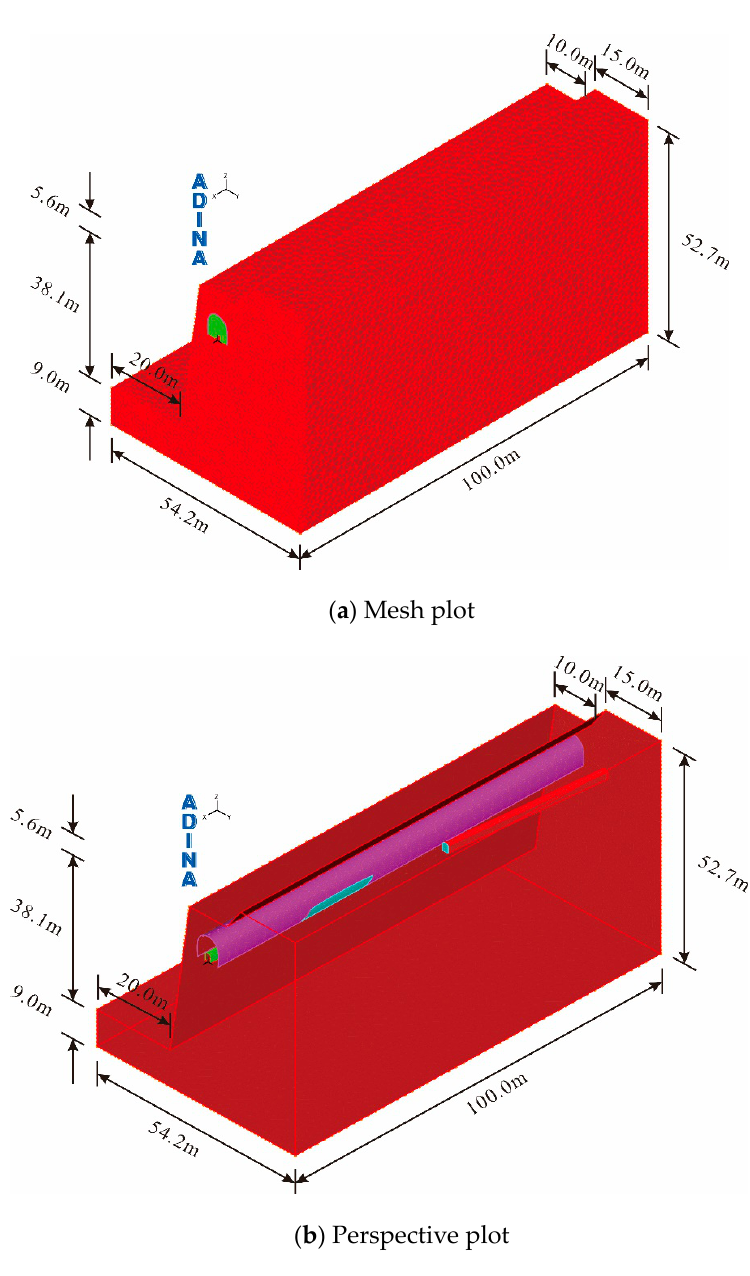
Figure 6. 3D size diagram of the numerical model.